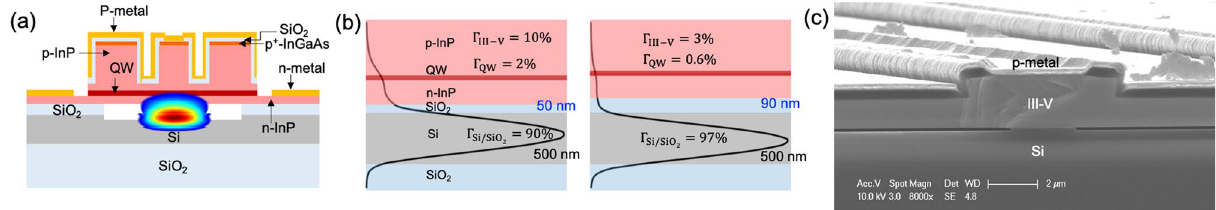
Figure 2. ( a ) Cartoon cross-sectional view of the laser device structure. ( b ) Transverse optical mode profile in the lasers with the 50 nm and 90 nm SiO 2 quantum noise control layer together with the confinement factor in each layer. c SEM image of the cross-section of the fabricated